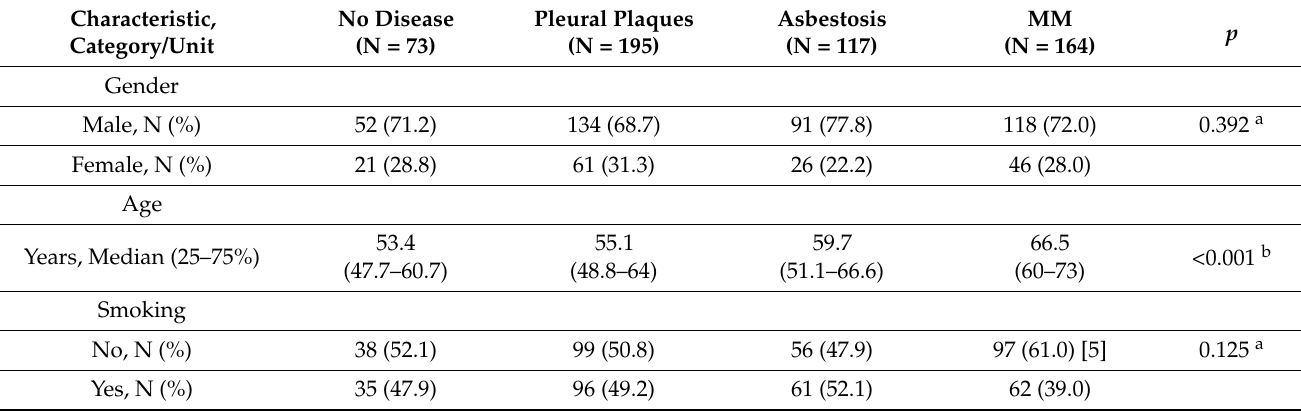
Table 1. Clinical characteristics of the subjects included in the study.